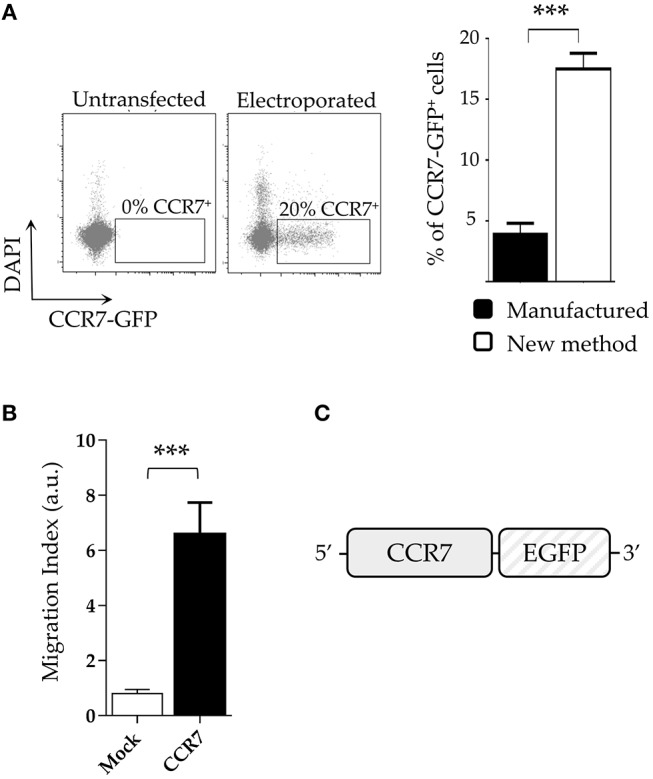
NK cells transfected with CCR7 plasmid acquire migratory capability. (A) Comparative expression of CCR7-GFP on DAPI-negative live IL-2-activated NK cells using the new protocol and the manufactured protocol (right panel). A representative experiment (left panel) out of 4 is shown (B) Migration index of CCR7+ and mock-electroporated NK cells derived from 5 different donors. ***p < 0.001. (C) Schematic reppresentation of the CCR7 construct.